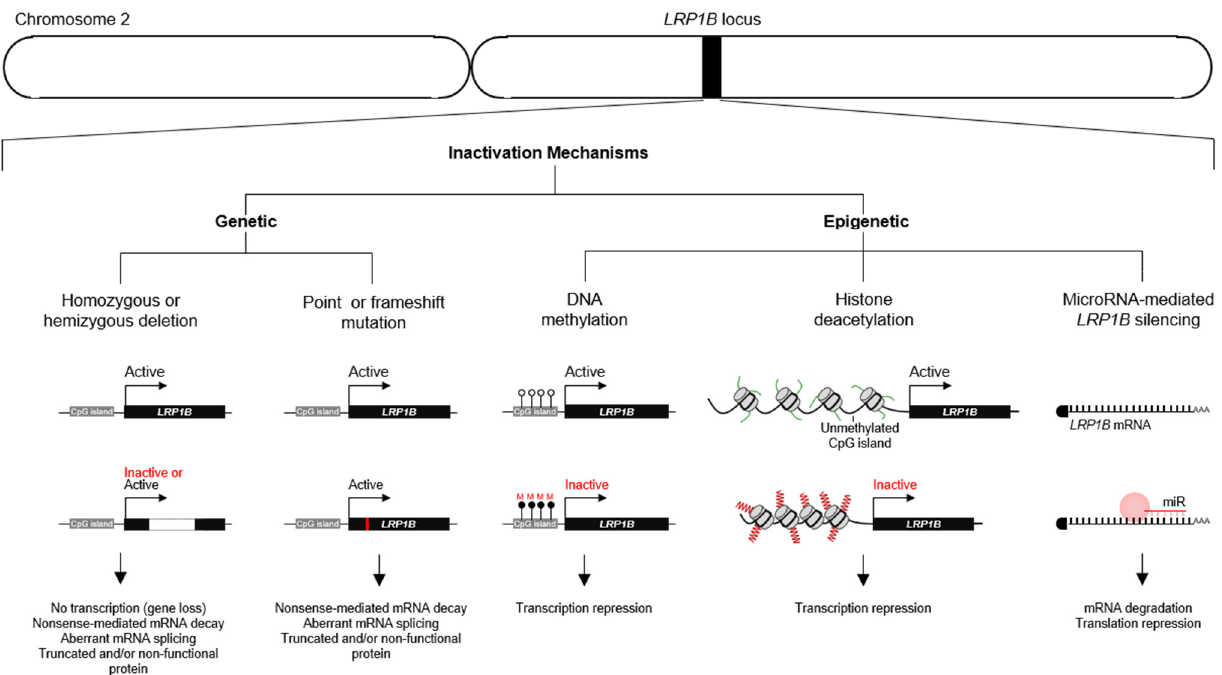
Figure 8. Mechanisms of genetic and epigenetic inactivation of LRP1B in cancer. Moreover, epigenetic mechanisms are known to affect LRP1B expression in several cancers; these include hypermethylation of CpG island located in the LRP1B promoter region [62,64,68,70,78,97–100], histone deacetylation of the LRP1B promoter region [78], and microRNA (miRNA)-mediated post-transcriptional regulation such as miR-548a-5p [thyroid cancer [62], miR-500 and miR-301b-3p, and prostate cancer [101,102]. Interestingly, LRP1B is also described as a common target gene for viral integration. This has been observed for hepatitis B virus (HBV) in liver cancer [103] and for human papillomavirus (HPV), resulting in LRP1B-downregulated expression in cervical cancers [104]. Over the years it was possible to confirm that LRP1B features the group of most altered genes across human cancers [21,59,62,65,68,69,78,97]. Recently, based on data from “The Cancer Genome Atlas TCGA” available on the cBioPortal database, Brown et al. showed that LRP1B somatic alterations were identified in approximately 12% across all samples and in more than 20% in multiples tumor types including NSCLC, melanoma, esophageal, stomach, head and neck, uterine, and bladder cancers [58]. Within the most common genetic alterations are LRP1B mutation, LRP1B loss, LRP1B R2553Q, LRP1B S2508F, and LRP1B E4182K (0.18%)